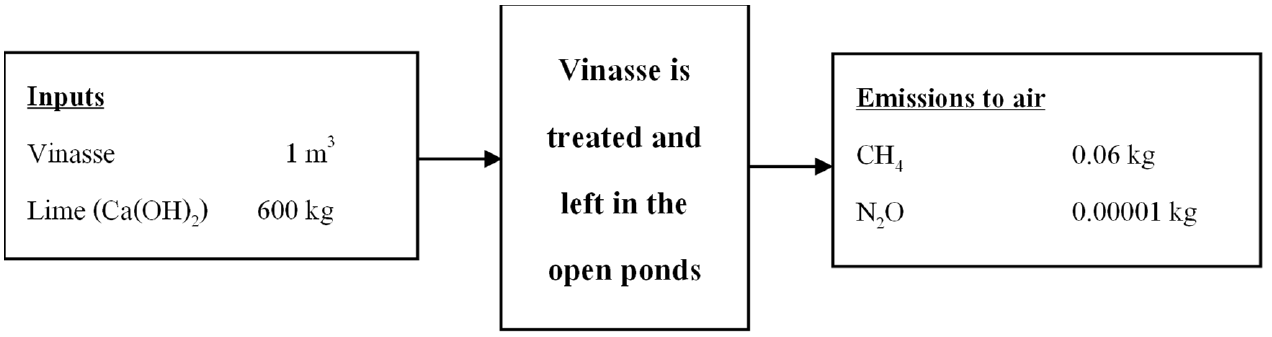
Figure A5. Inputs-Outputs of Scenario BV: Vinasse is treated and left in the open ponds. Remark: Data is referred from [52]; Lime used is referred from [53].